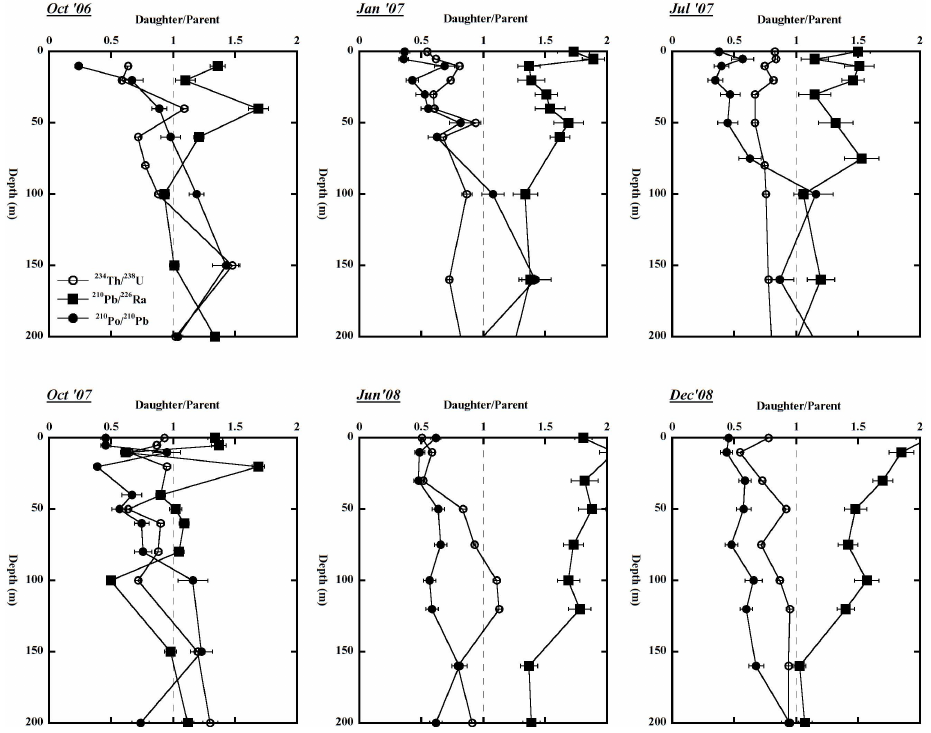
Fig. 6. Vertical distributions of the ratios of total activities of daughter and parent radionuclides obtained from the six cruises. The dotted line represents the secular equilibrium of daughter-parent relationship. Error bars represent uncertainty based on propagated counting errors ( ± 1 σ